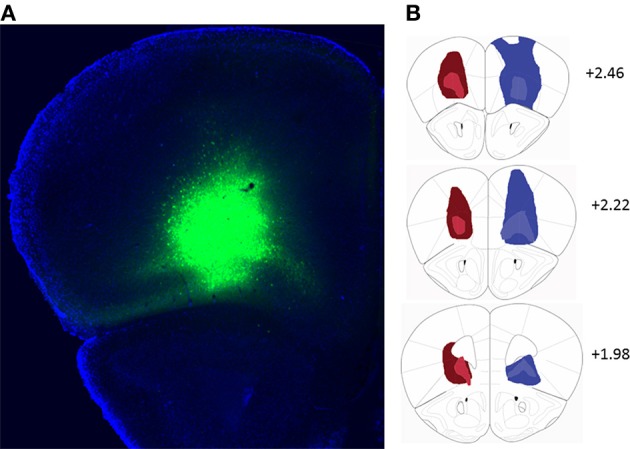
(A) Representative example of viral expression in the orbitofrontal cortex. (B) Diagrammatic representation of the spread of hM4D(Gi)-mCitrine (red) and GFP (blue) virus. All injections were bilateral. For clarity, the minimal (light colors) and maximal (dark colors) extent of each type of injection is depicted only on one hemisphere. Numbers indicate relative distance from bregma according to Paxinos and Franklin (2001). hM4D(Gi) N = 11, GFP N = 12.